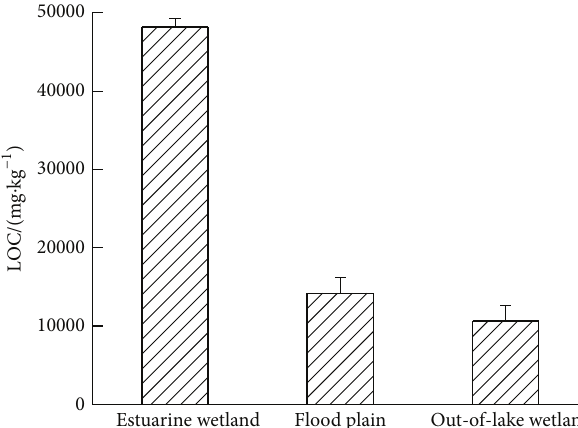
Figure 3: Changes of DOC content under different types of wetland in Hongze Lake of China.